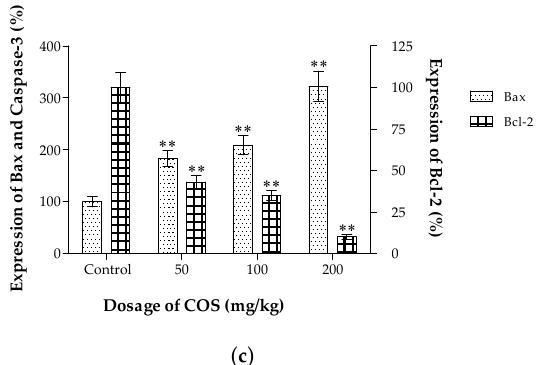
Figure 6. Immunohistochemical detection on Lewis tumor tissue (original magnification, 100×). ( a ) Photographs of Bax expression in Lewis tumor tissue; ( b ) Photographs of Bcl-2 expression in Lewis tumor tissue; ( c ) Effects on Bax and Bcl-2 expression of Lewis tumor tissue were quantified by Image Pro Plus software. The relative average optical density of the control group was adjusted to 100%. Data represents mean ± SD, n = 12, ** p < 0.01 significant difference compared with control group. Arrow: high expression of immune proteins.